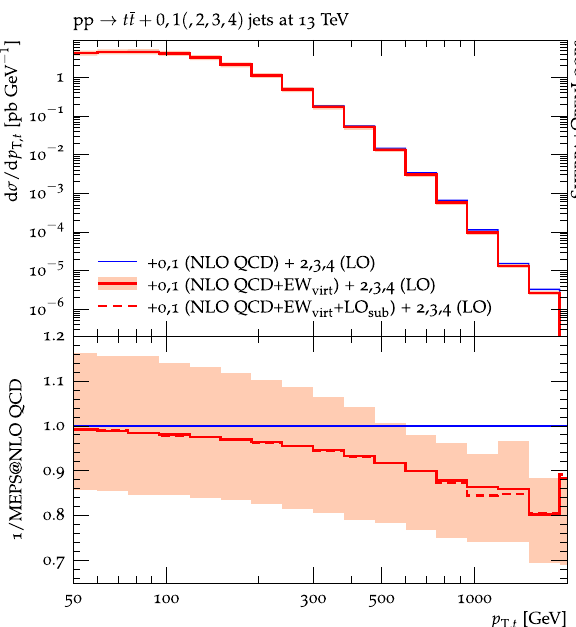
Fig. 3 Top-quark transverse momentum distribution (left) and top- antitopinvariantmass(right)atparton-levelwithstabletopsfortheLHC with 13 TeV. Compared are MePs@Nlo QCD and MePs@Nlo QCD